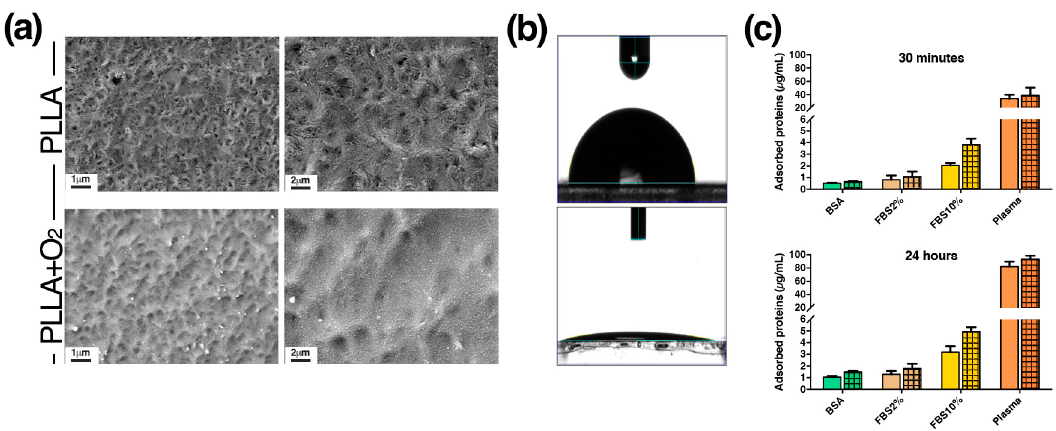
Figure 1. PLLA and PLLA+O 2 polymer films. ( a ) Representative FESEM images of PLLA and PLLA+O 2 surface morphology; ( b ) WCA images of PLLA and PLLA+O 2 surfaces (see method for details); and ( c ) protein adsorption is reported as mean ± SEM. Clear fill bar: PLLA; patterned fill bar: PLLA+O 2 .